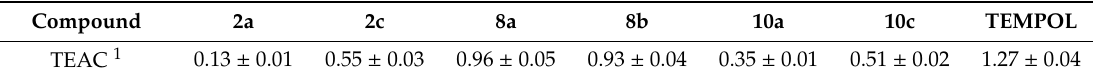
Table 1. TEAC activity of